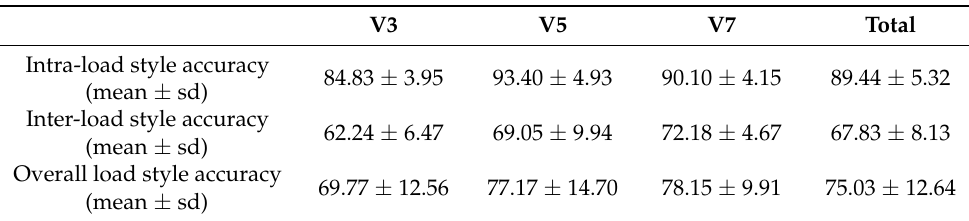
Table 3. Intra- and inter-load styles and the overall accuracy of gait recognition (%) (mean ± SD) across the three speeds.